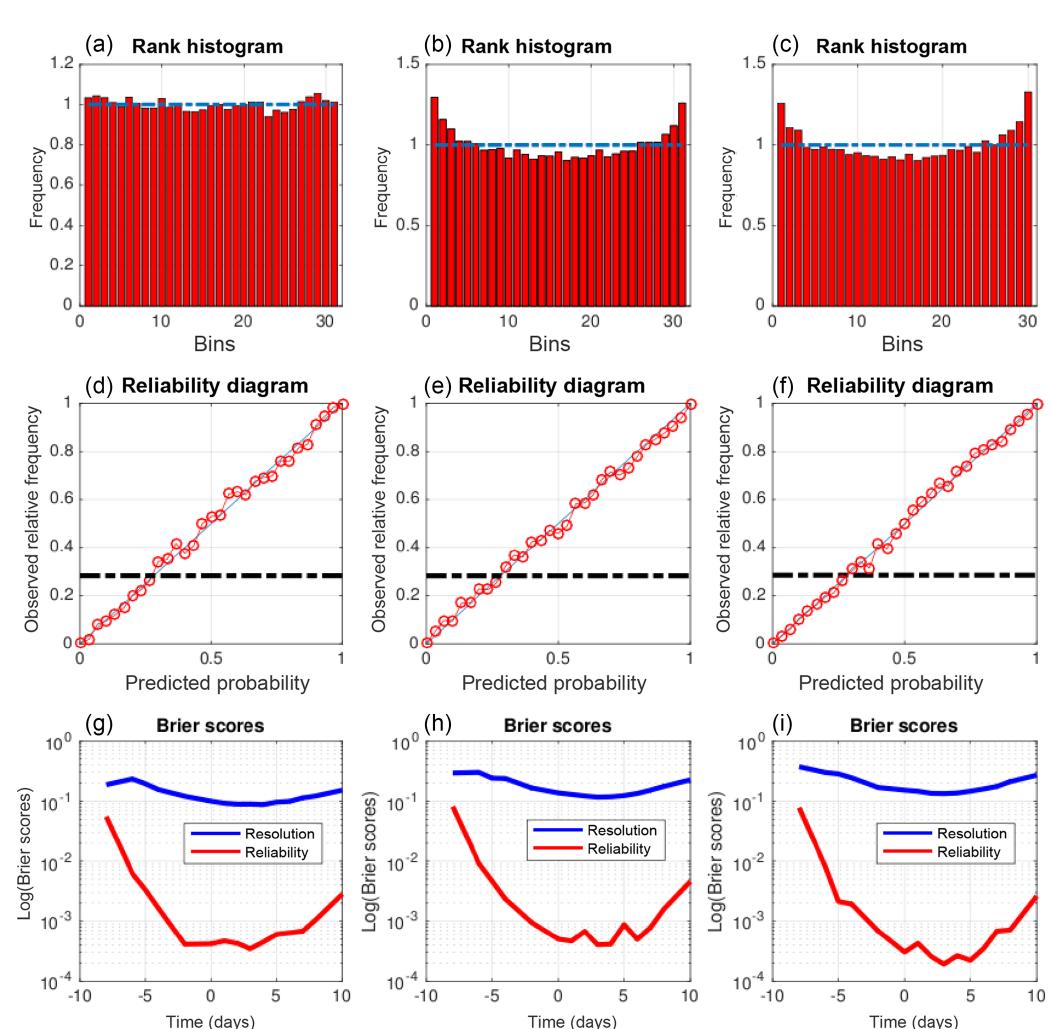
Figure 12. Compared performance of EnsVAR, EnKF, and PF (columns from left to right respectively) over the last 13 days of 18-day assimilation windows. (a, b, c) Rank histogram. (d, e, f) Reliability diagram for the event E = { x > 1 . 02 } , which occurs with frequency 0.27. (g, h, i) Reliability and resolution components of the Brier score for events x < τ as functions of the threshold τ